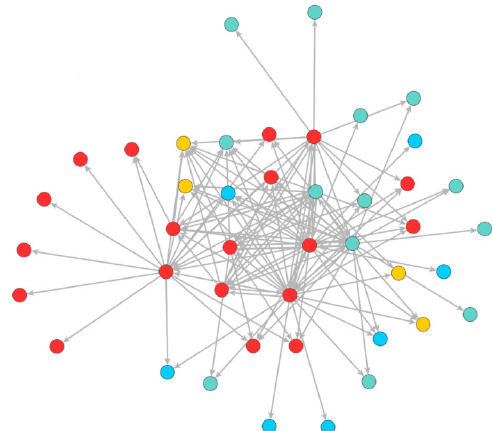
Figure 2. Power in Case 2.